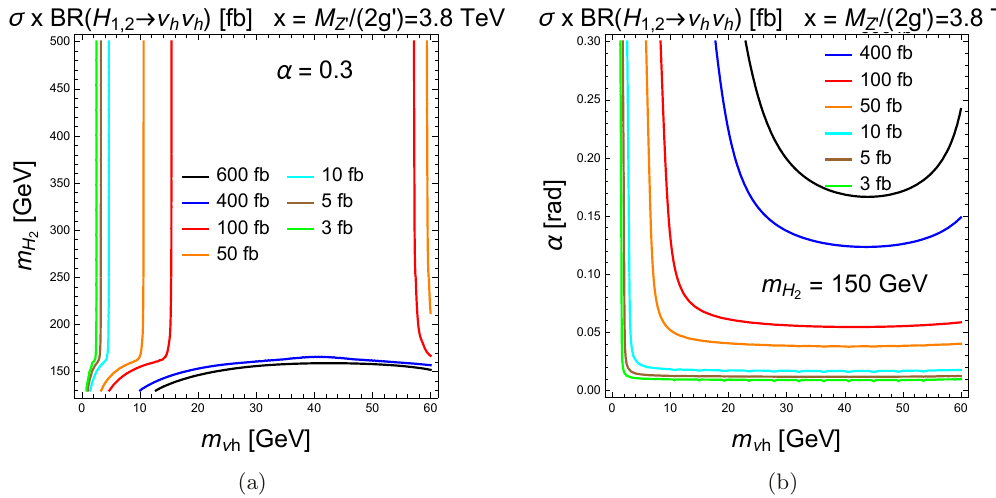
Figure 4 . (a) Contour plots of the cross section times BR for the process pp the LHC with √ S = 13 TeV in the (a) ( m ν and g ′ 0 . 65. Notice that the cross sections for the channels induced by both H 1 and H 2 have ≃ been summed together. The interference is found to be negligible.